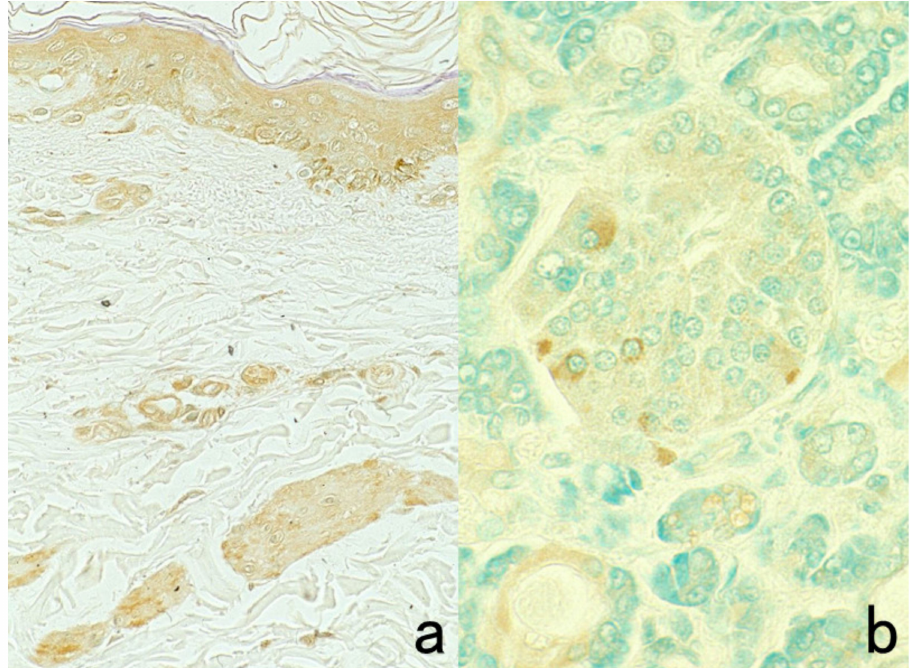
Figure 48. Myoglobin immunostaining in the skin ( a ) and pancreas ( b ) using a commercial rabbit antiserum. Rabbit antiserum available from Agilent/Dako may contain natural antibodies against intermediate filament proteins. In the skin, epidermal keratinocytes, vascular endothelial cells, and smooth muscle cells of erector pili are weakly stained. In the pancreas, some islet cells are faintly immunostained by the incidentally contaminating antibodies. The nuclei in panel ( b ) are counterstained with methyl